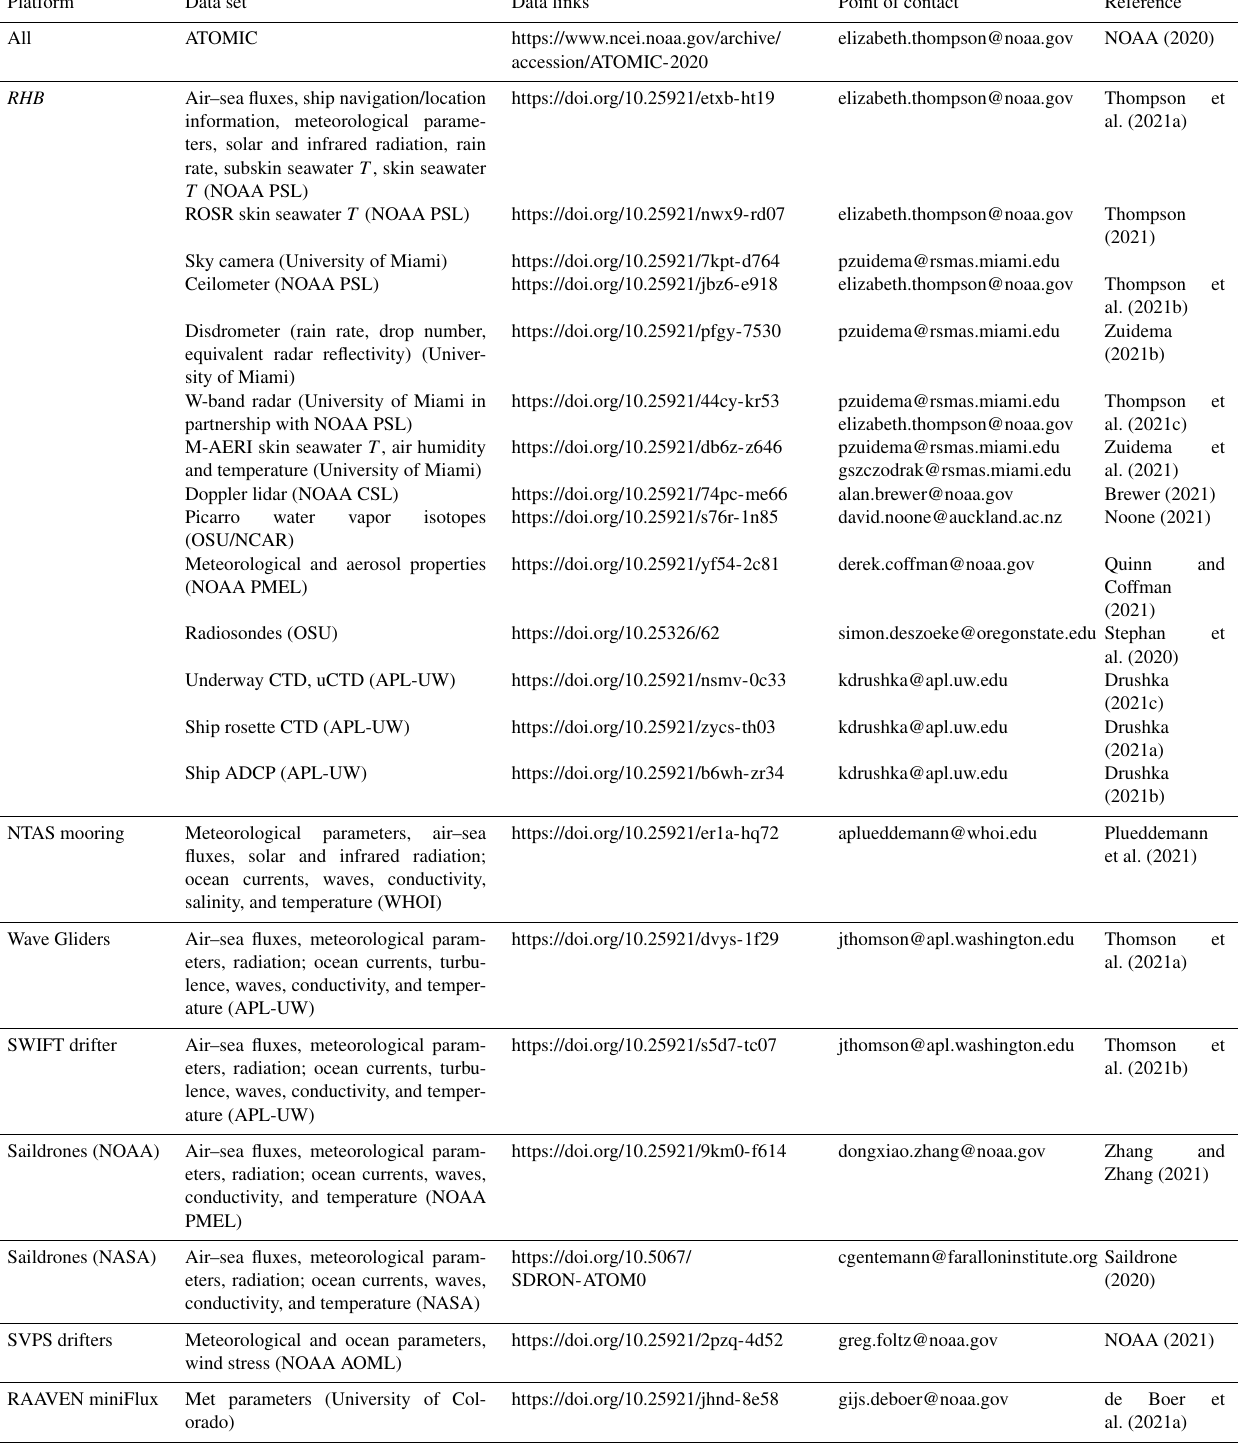
Table 11. Summary of data sets and DOIs, point-of-contact information, and references for data collected on board the RV Ronald H. Brown , NTAS, Wave Gliders, SWIFTs, NOAA- and NASA-operated Saildrones, and RAAVEN UAS during ATOMIC. The data are permanently and publicly available at